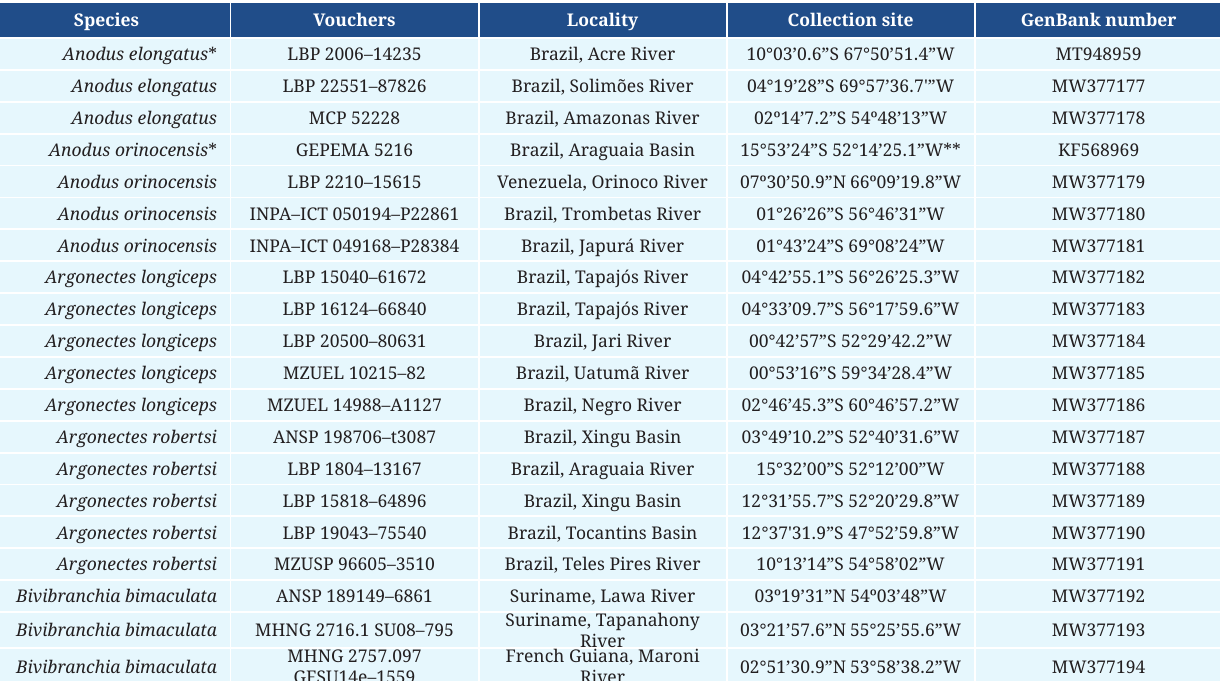
TABLE 1 | Geographic and catalogue museum information of the voucher specimens utilized in this study. *Downloaded from GenBank; ** Approximate